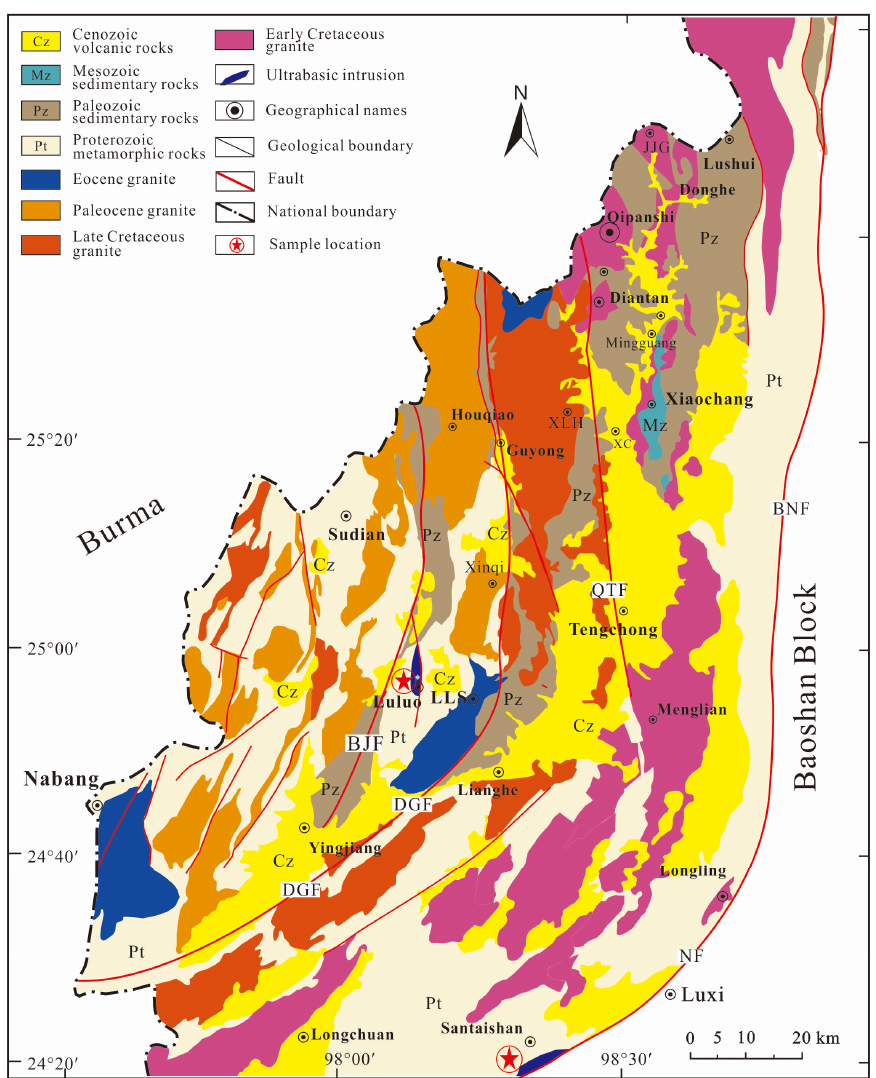
Figure 2. Simpli fi ed geological map showing the major geologic units of the Tengchong Block (TCB), the spatial-temporal distribution of the ultrama fi c and sample localities in this study (modi fi ed